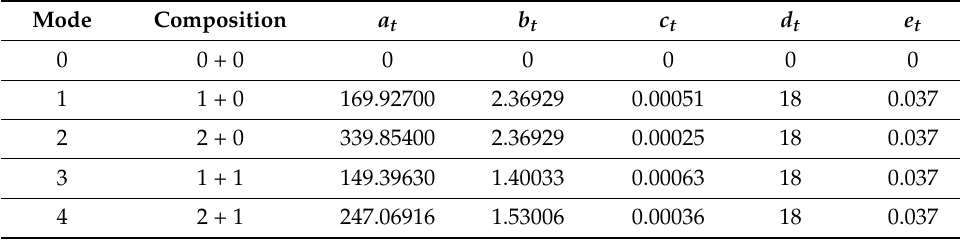
Table 5. Cost curve coefficients data for